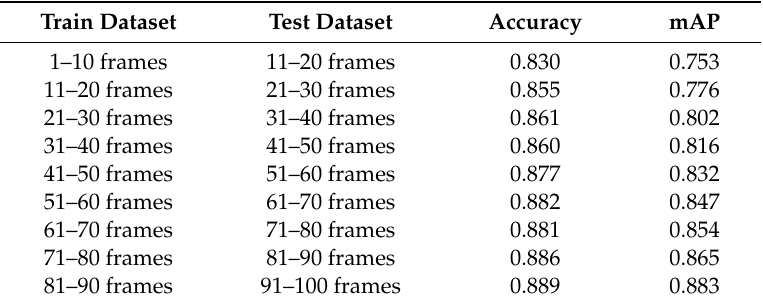
Figure 11. Receiver operating characteristic (ROC) curve of the BP neural network. Figure 11. receiver operating characteristic (ROC) curve of the BP neural network. Table 2. Result of the BP neural network for di ff erent Table 2. Result of the BP neural network for different frames.